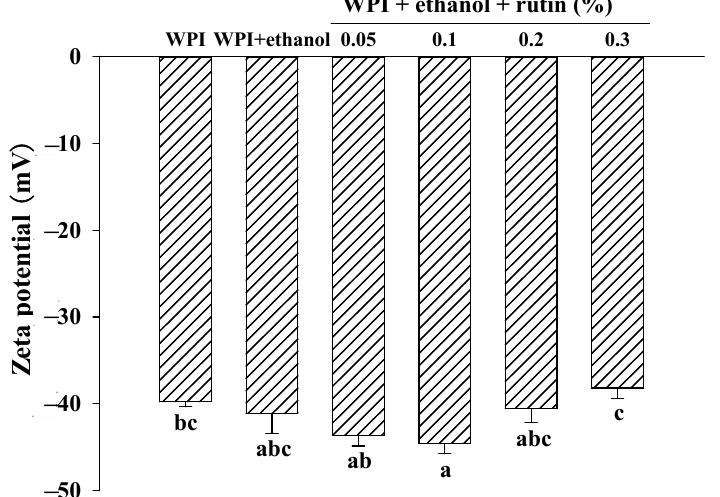
Figure 5. The effects of ethanol (15% v / v ) and different levels of rutin (0.05%, 0.1%, 0.2% and 0.3% w / v ) on the zeta-potential of WPI. Means with different letters (a–c) differ significantly ( p < 0.05).